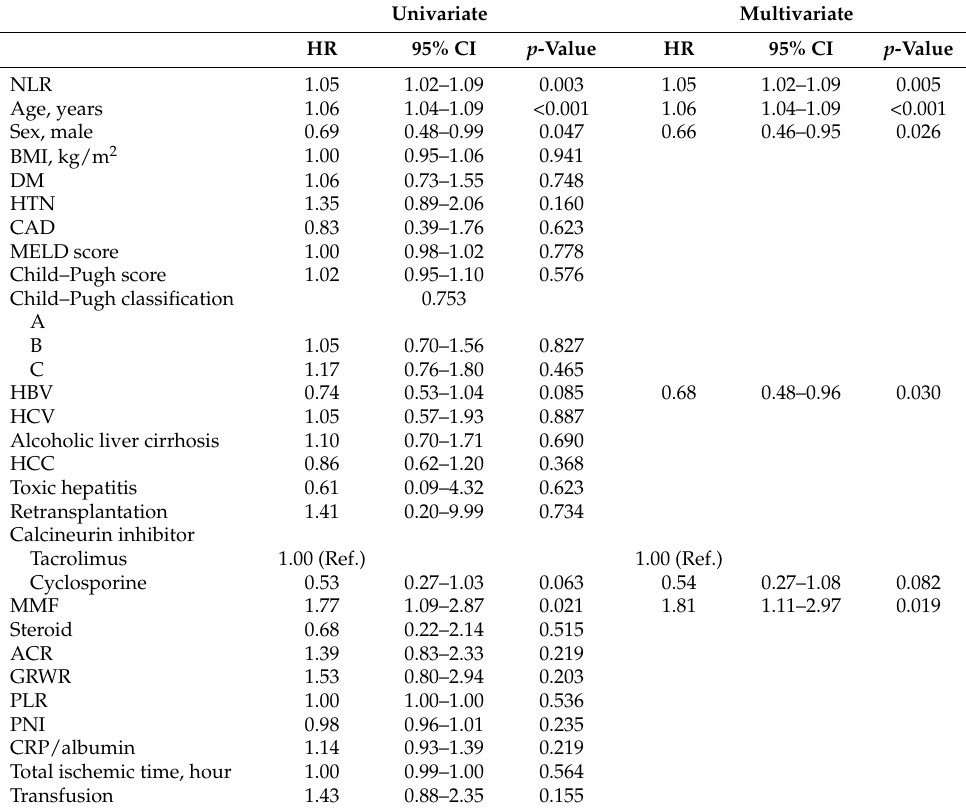
Table 2. Cox regression analysis of the risk factors associated with herpes zoster.